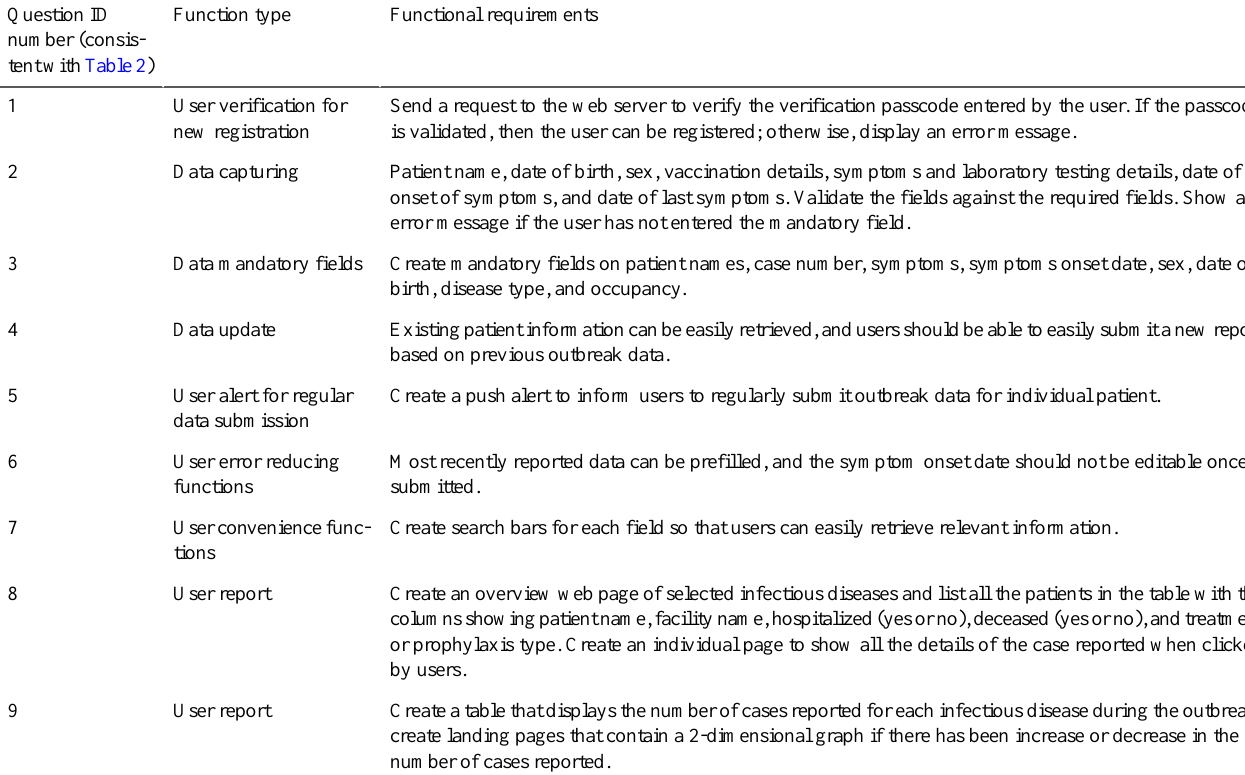
Table 3. The list of functional requirements formulated based on the outcomes of